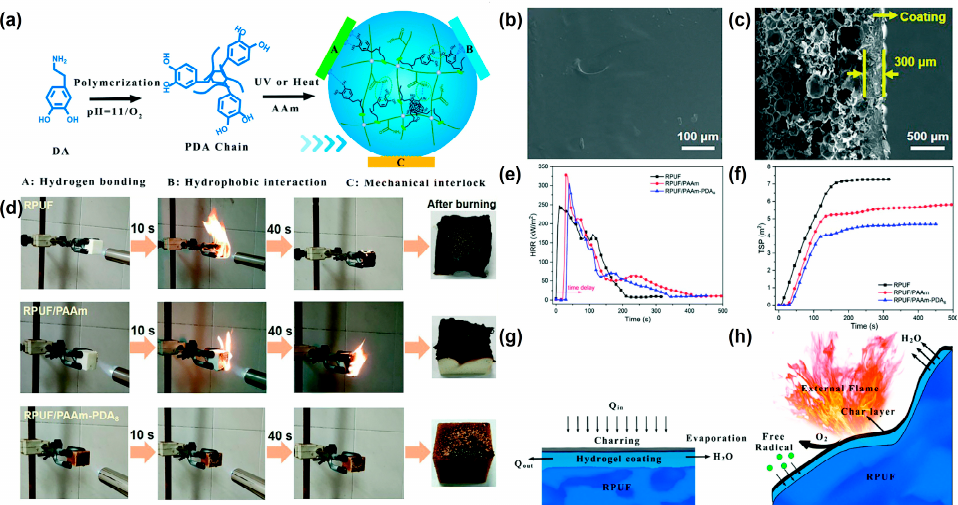
Figure 1. ( a ) Schematic diagram of the synthesis route of the PAAm–PDA hydrogel, ( b ) SEM image of the surface of the hydrogel-coated RPUF, ( c ) SEM image of the cross-sectional structure of the hydrogel-coated RPUF, ( d ) video screenshot of the burning process of uncoated and hydrogel-coated RPUF under the propane flame for 10 s, ( e ) HRR and ( f ) TSP curves of uncoated and hydrogel-coated RPUF, ( g ) and ( h ) are schematic of the flame-retardant mechanisms of the hydrogel-coated RPUF [29].